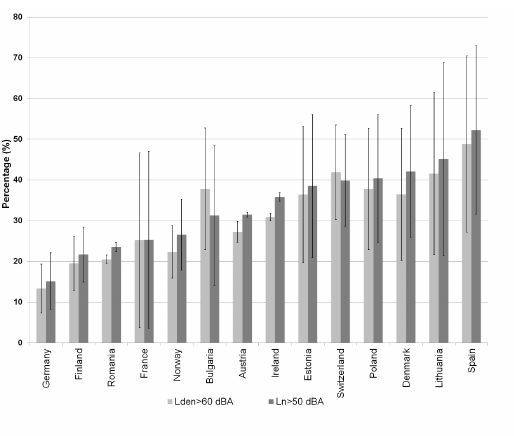
Figure 5: Percentage of the population (considering the total pop- ulation of the agglomerations where strategic noise maps were realized) exposed to traflc noise in European